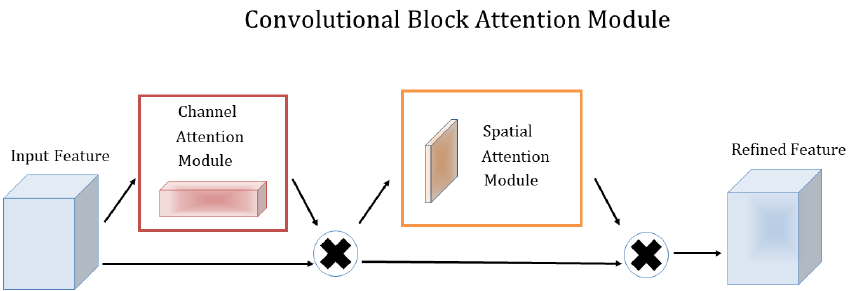
Figure 3. Illustration of convolutional block attention module.